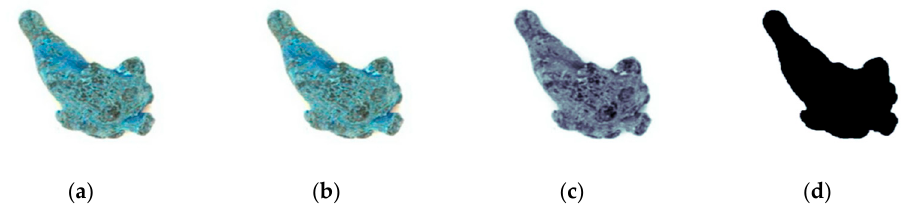
Figure 3. Image preprocessing. ( a ) Original image, ( b ) Gaussian filtered, ( c ) grayscale image, ( d ) binarized image.